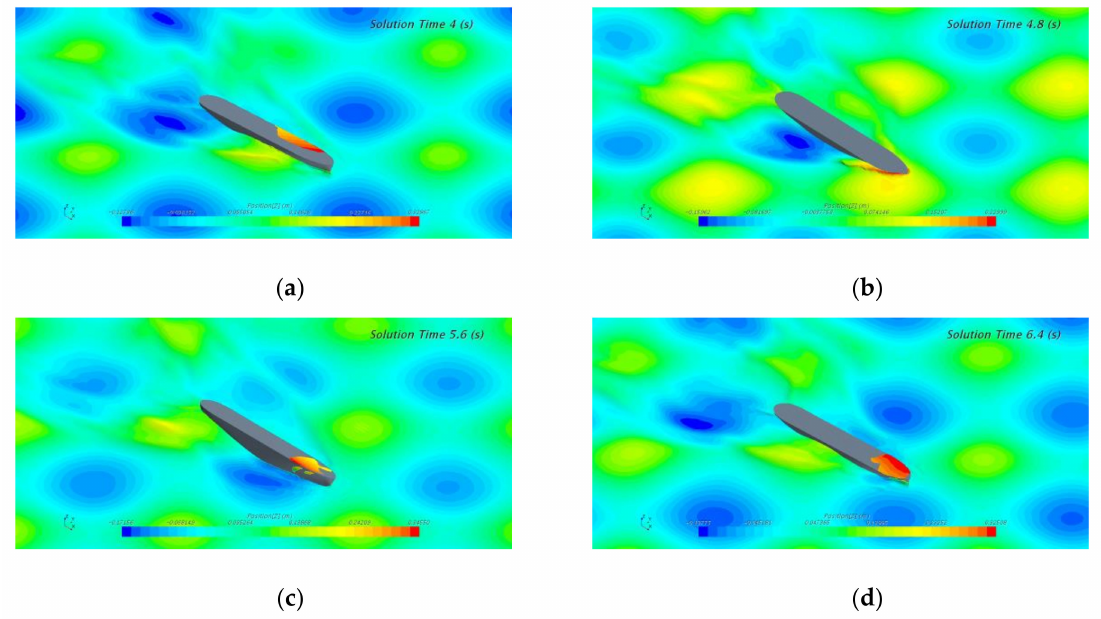
Figure 20. Ship large amplitude roll motion process at wave heading 90 ◦ (45 ◦ / 135 ◦ ): ( a ) t = 4 s; ( b ) t = 4.8 s; ( c ) t = 5.6 s; ( d ) t = 6.4 s.